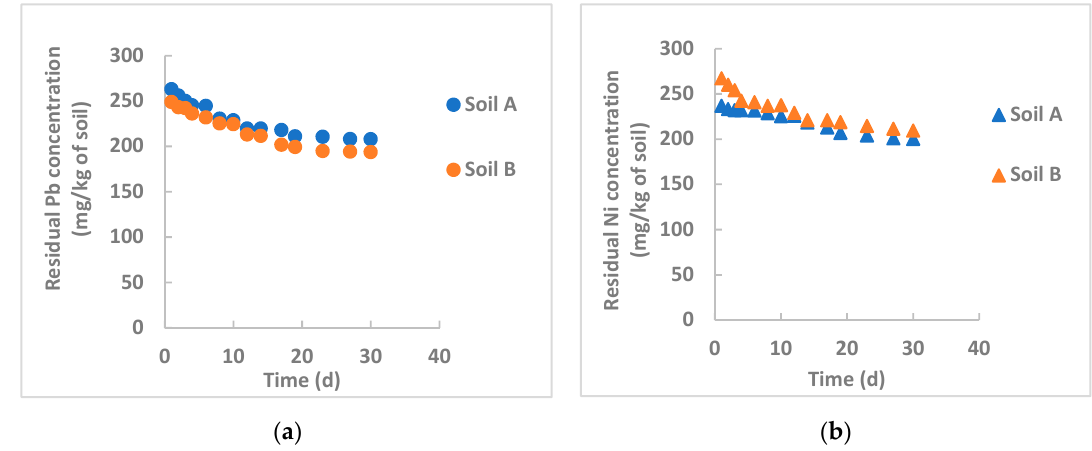
Figure 3. Remediation of contaminated soil using chemically synthesized nZVI particles (dosage: 0.1 g/kg of soil): ( a ) lead removal; ( b ) nickel removal.